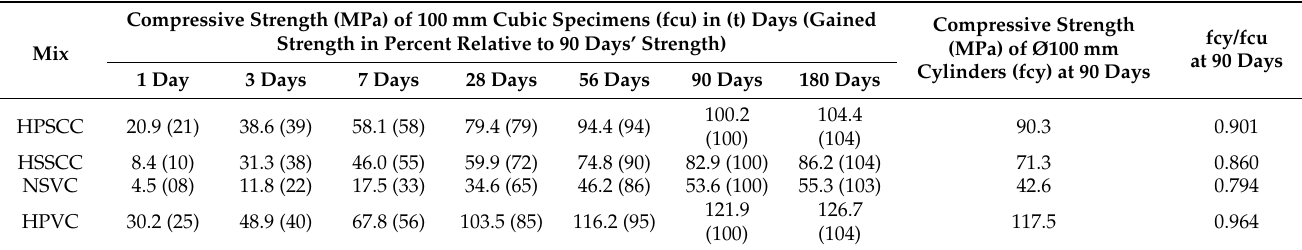
Table 6. Compressive strength of 100 mm cubes at 7 ages, and Ø100 mm